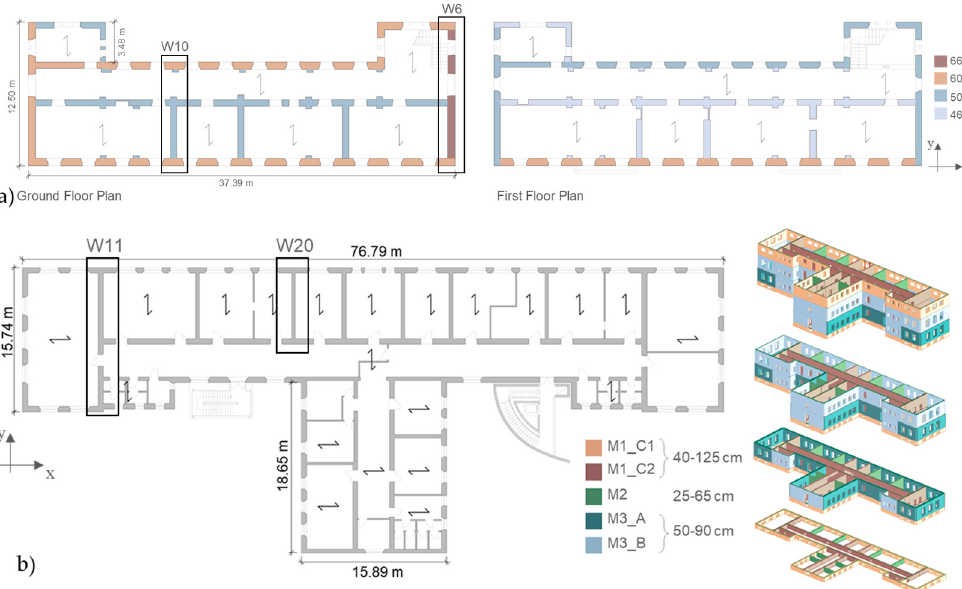
Figure 19. In-plan view of the Pizzoli’s town hall ( a ) and the former courthouse of Fabriano ( b ) with the indication of wall’s thickness and location of various masonry types.